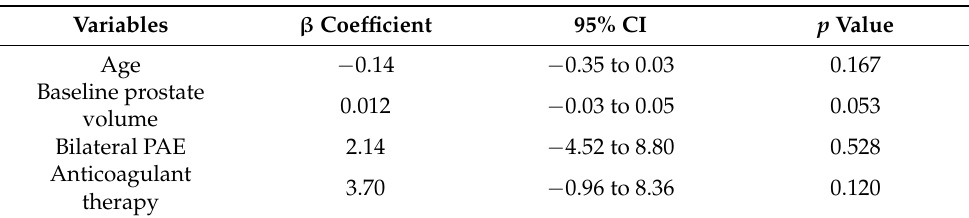
Table 4. Multivariate analysis: factors independently associated with the IPSS improvement at month 3 vs. baseline.